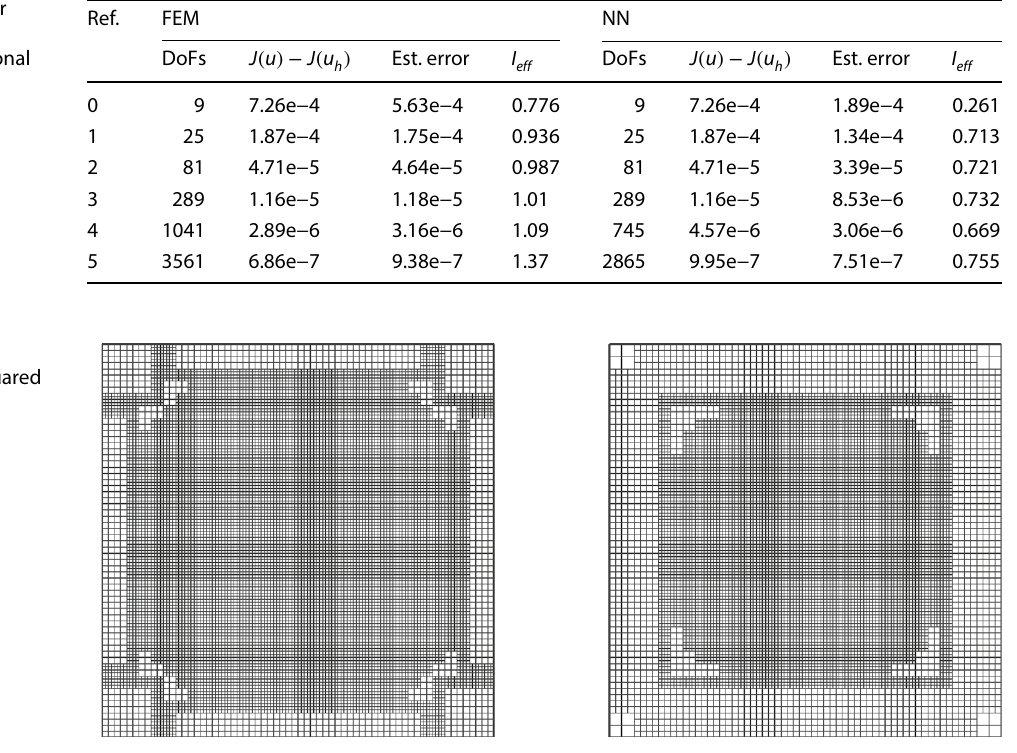
Table 3 Section 5.1.3: Error estimator results for mean squared value goal functional